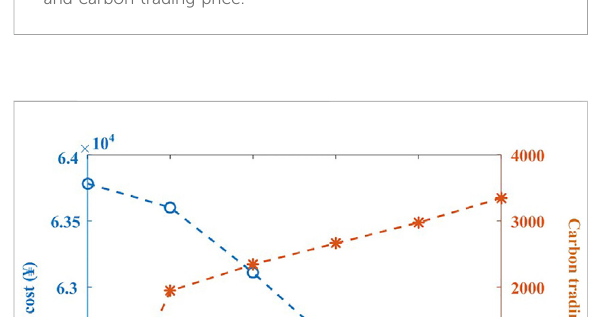
FIGURE 6 Relation curve between operation cost, power purchase cost and carbon trading price.